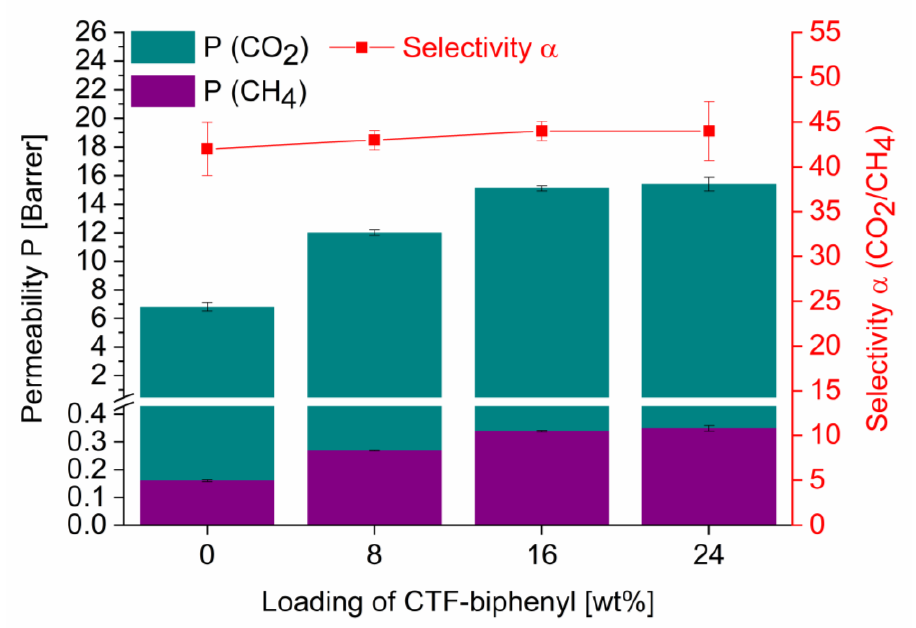
Figure 2. CO 2 and CH 4 permeabilities ( P ) and CO 2 /CH 4 selectivities ( α ) for the pure Matrimid ® membranes and CTF/Matrimid ® MMMs.